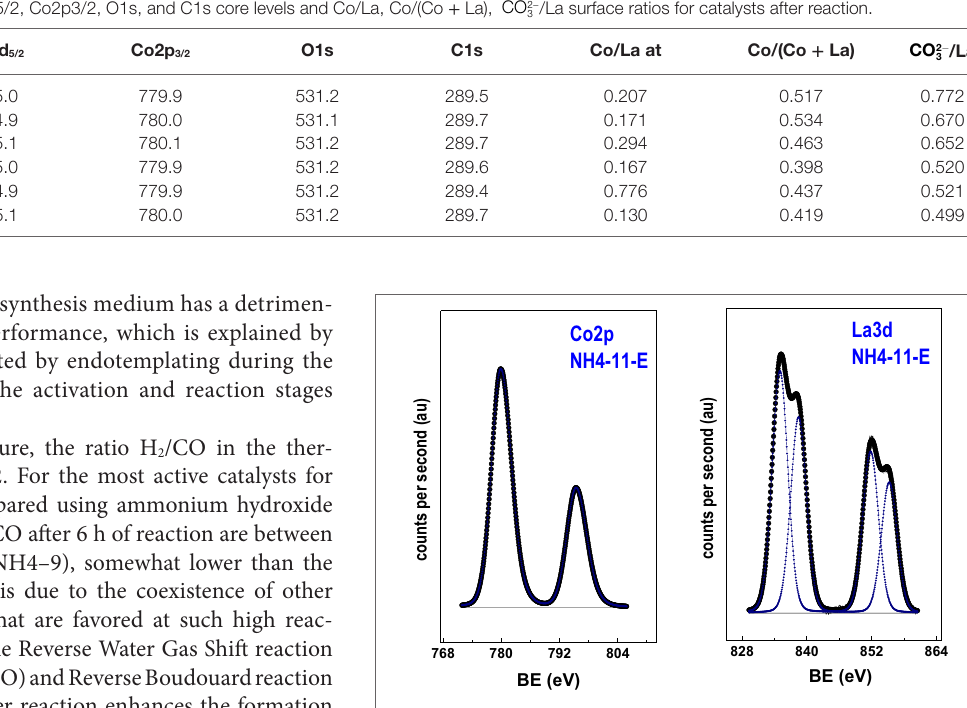
FigUre 7 | Co2p and La3d X-ray photoelectron spectroscopy spectra of spent NH4–11-E catalyst after catalytic partial oxidation of methane